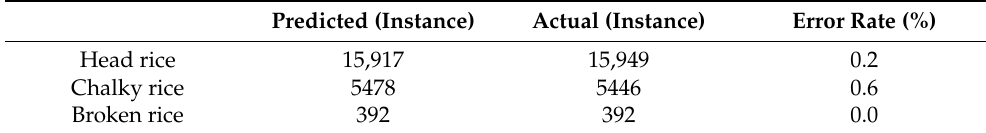
Figure 13. Image visualization of a single polished rice grain. Table 6. Statistical results of rice grain types after improvement. Table 6. Statistical results of rice grain types after improvement.